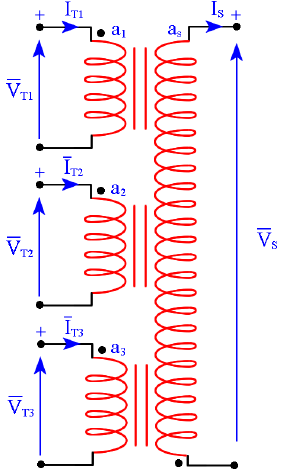
Figure 11. Rotor coupling of three blades modelled as an electric transformer.